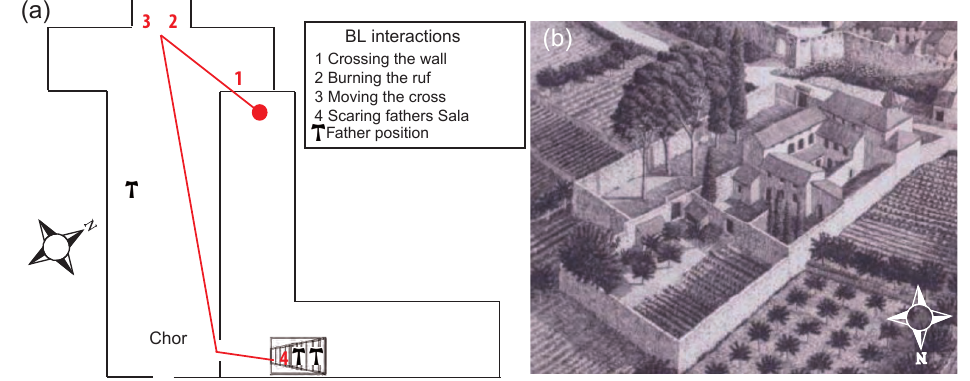
Figure 3. (a) Schematic map of monastery of Pi with the motion of the ball lightning. (b) Detail of the Approximate view of Oliva around 1850 by Enrique Bofí Planes (courtesy of the Museo Nacional de Cerámica y Artes Suntuarias González Martí).